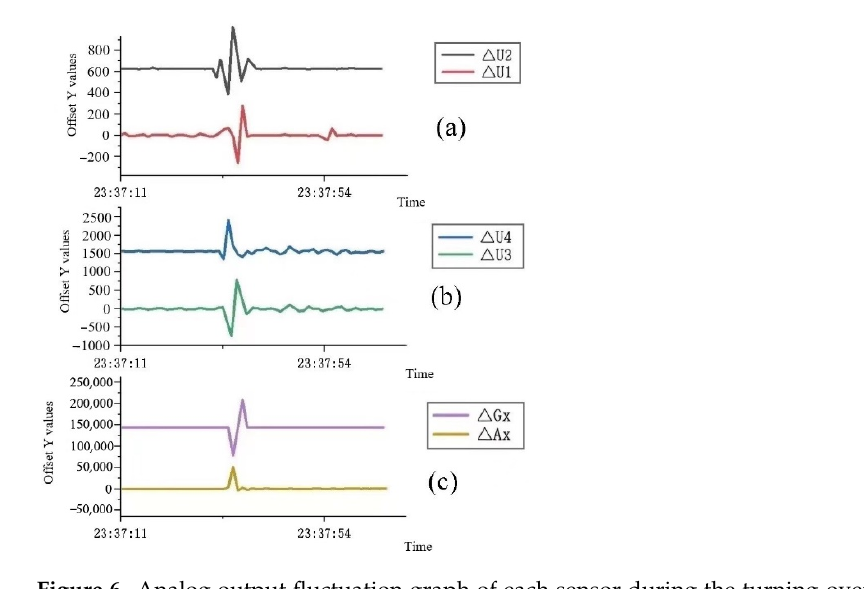
Figure 6. Analog output fluctuation graph of each sensor during the turning-over action: ( a ) the analog output voltage change curves of the left and right lateral lumbar flexible angle sensors, ∆ U1 and ∆ U2, are the analog output voltage change values of the left and right lumbar flexible angle sensors after bending, respectively; ( b ) the analog output voltage change curves of the upper and lower spine flexible angle sensors, where ∆ U3 and ∆ U4 are the analog output voltage change values of lower and upper spine flexible angle sensors after bending, respectively; ( c ) the acceleration and angular velocity analog output change curves of the six-axis motion sensor, where ∆ Ax and ∆ Gx are the lumbar motion sensor’s analog output acceleration and angular velocity change values, respectively.